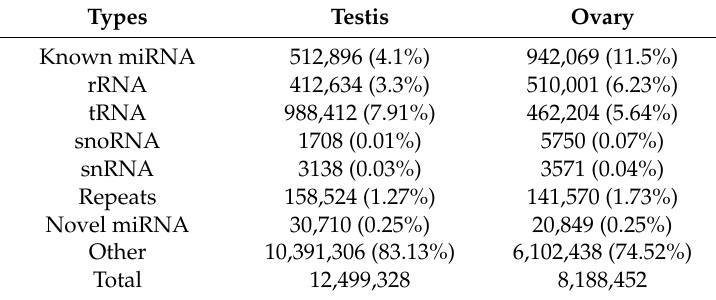
Table A3. Classification of the obtained small